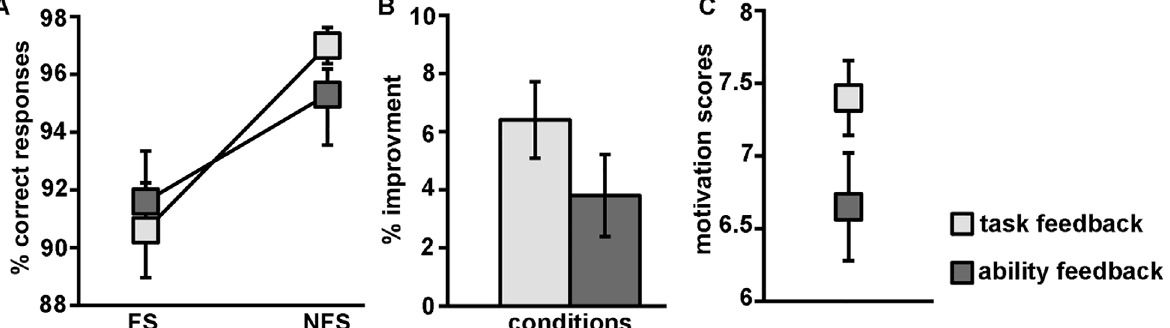
Fig 2. Performance improvement and motivation scores for task and trait-feedback during FS and NFS. A) Both feedback conditions resulted in performance improvement from FS to NFS. B) Task-feedback led to greater improvement compared to trait-feedback (NFS vs. FS). C) The participants were more motivated to continue with the task after task-feedback compare to